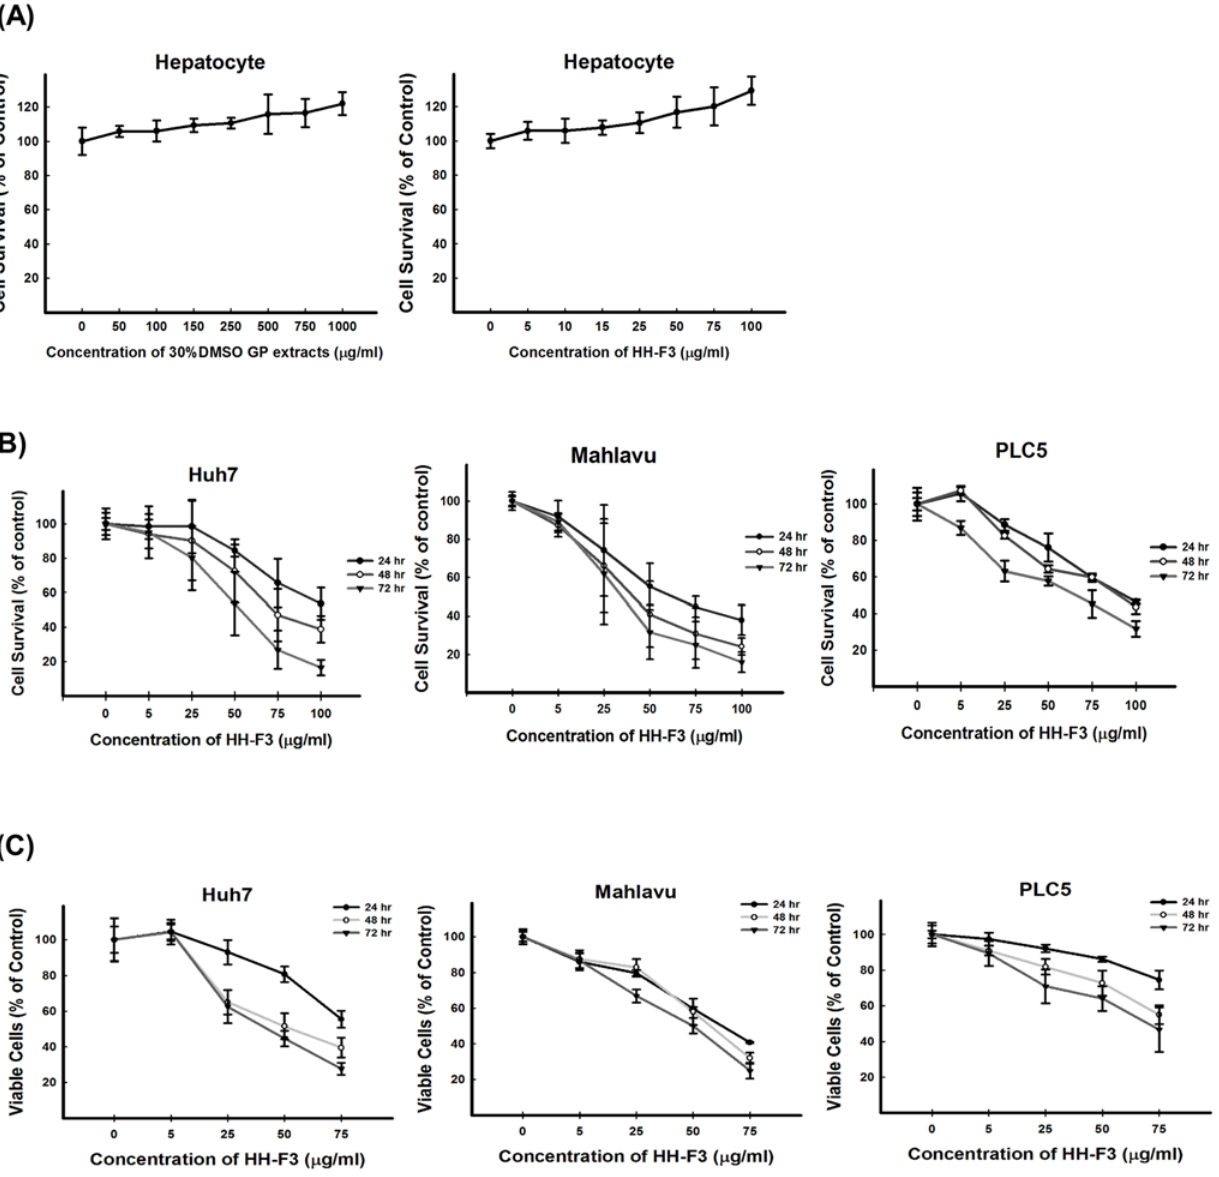
Fig 2. The HH-F3 fraction inhibits the growth of HCC cells. (A) Human hepatocyte were treated with various concentrations of 30% DMSO GP extracts/ HH-F3 for 72 hrs. Data are expressed as the mean ± standard deviation (SD) of three independent experiments. Huh7, Mahlavu and PLC5 cells were treated with 5, 25, 50 and 75 μ g/ml of the HH-F3 fraction at for 24, 48 and 72 hrs then subjected to the MTT assay (B) and trypan blue assay (C). The IC 50 concentrations of HH-F3 for the growth inhibition of Huh7, Mahlavu and PLC5 cells were approximately 50, 37.5 and 75 μ g/ml, respectively, after 72 hrs of